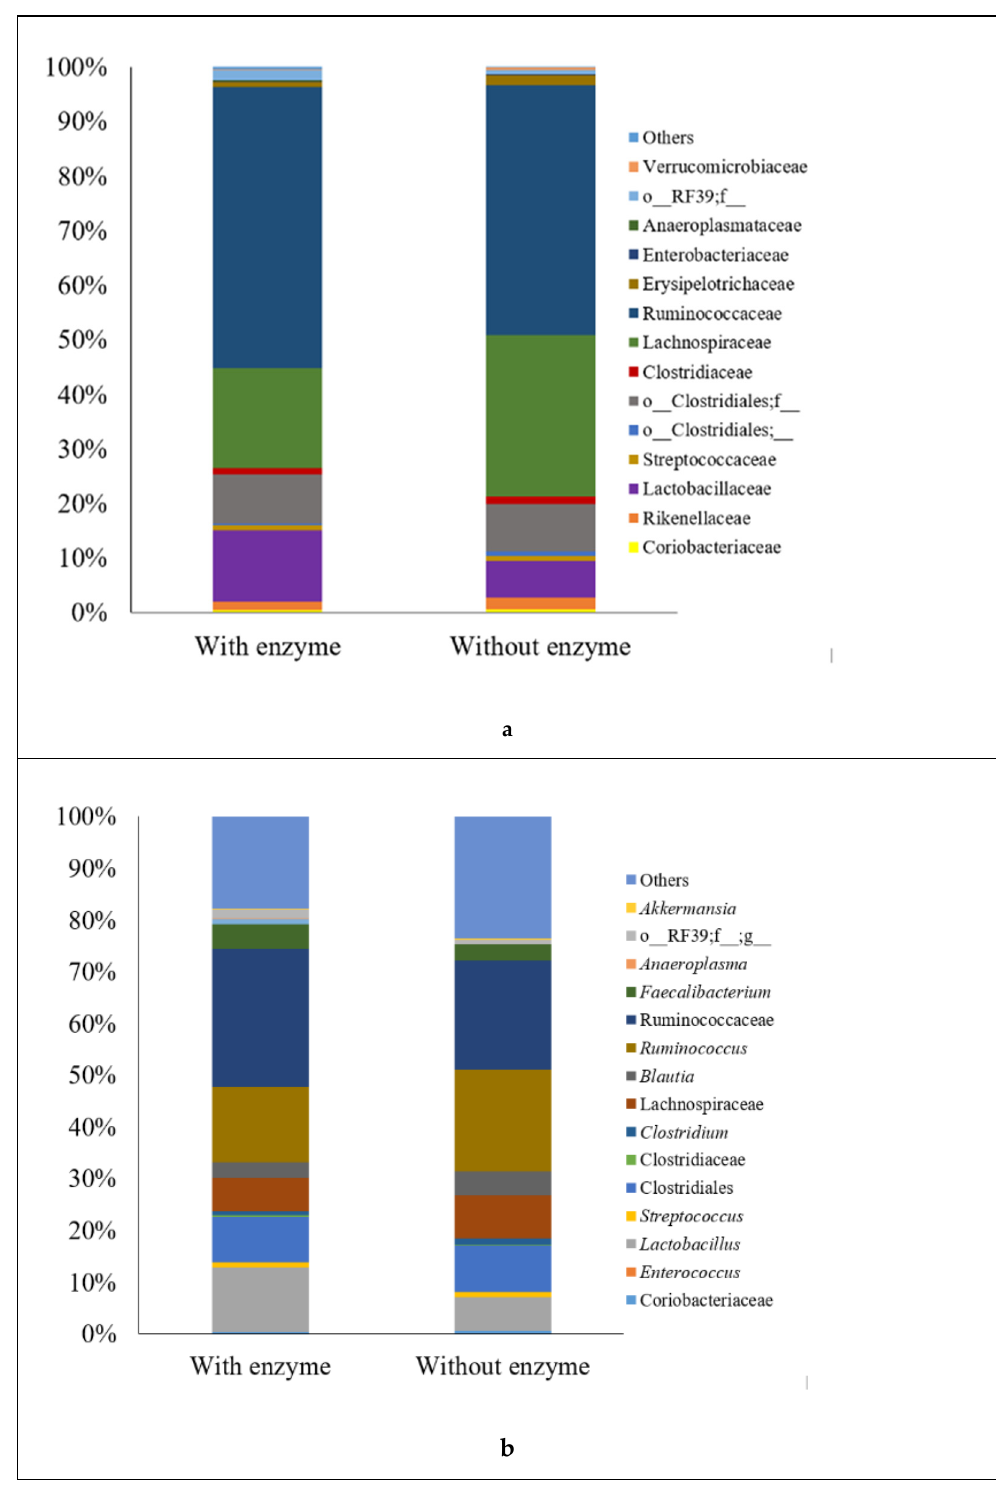
Figure 2. ( a ) Predominance of bacterial families and ( b ) bacterial genera present in the cecal microbiota of broilers at 21 days of age fed diets with or without inclusion of an enzymatic blend. The non-italicized groups represent bacteria that were identified to order- or family-level.